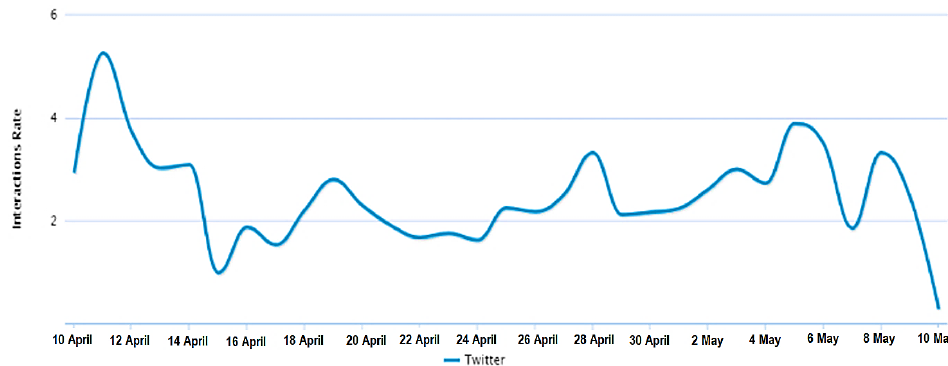
Figure 2. Trends in discussions about LSSR.